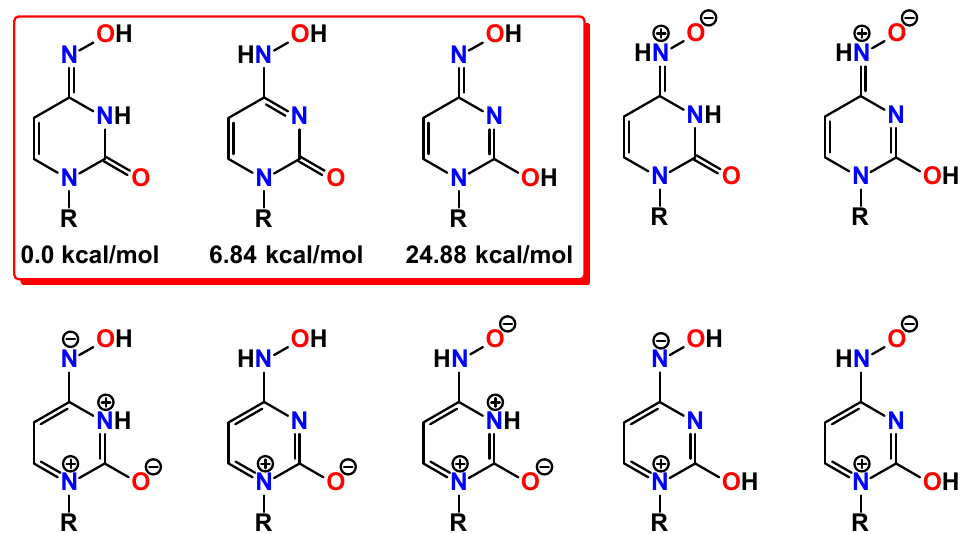
Figure 2. Diagrams of the plausible tautomers of the N 4 -hydroxylcytosine fragment in the molecule of molnupiravir (R = residue of the molecule of molnupiravir).